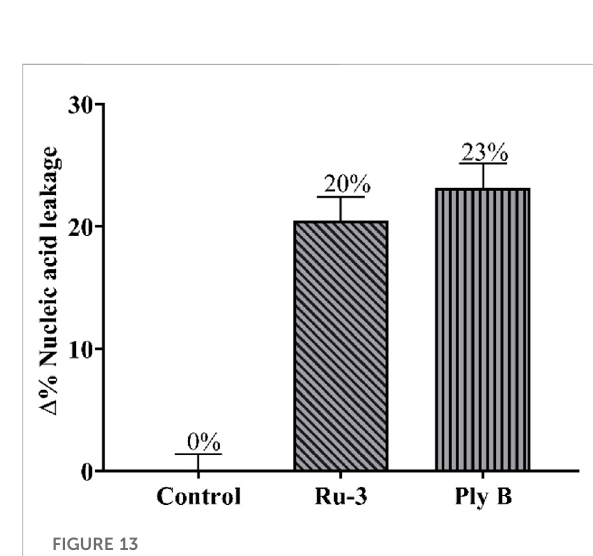
FIGURE 12 Plasma membrane permeability of Staphylococcus aureus cells treated with Ru-3 (2 μ g/ml or 4 μ g/ml) and vancomycin (2 μ g/ml).